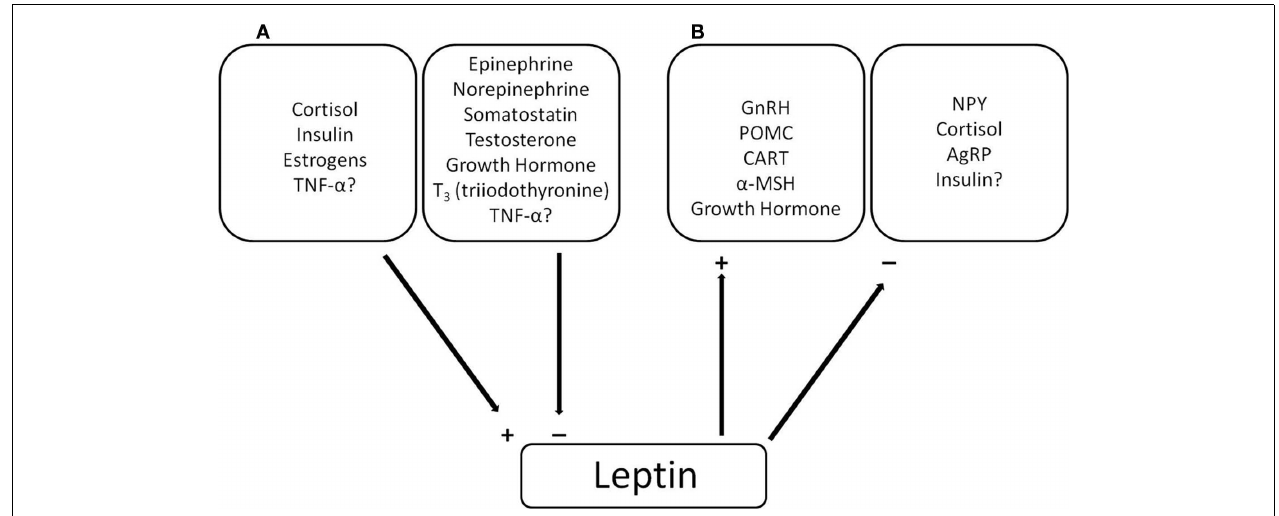
FIGURE 1 | (A) The effects of various peptides/hormones on leptin expression/secretion in mammals. (B) The effect of leptin on the expression/secretion of various peptide/hormones.The + and − indicate stimulatory and inhibitory effects respectively. Findings are reviewed in Rayner andTrayhurn (2001) and Reidy andWeber